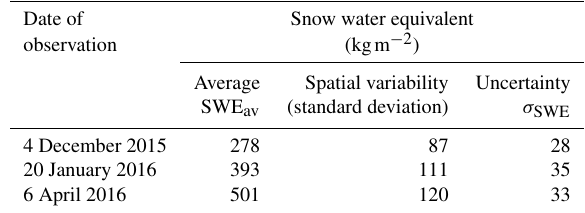
Table 8. The average SWE observed on the ski slope (SWE av ) along with the standard deviation of the raster values within the study area (Fig. 7) and the uncertainty ( σ SWE ) resulting from the computation in Sect.